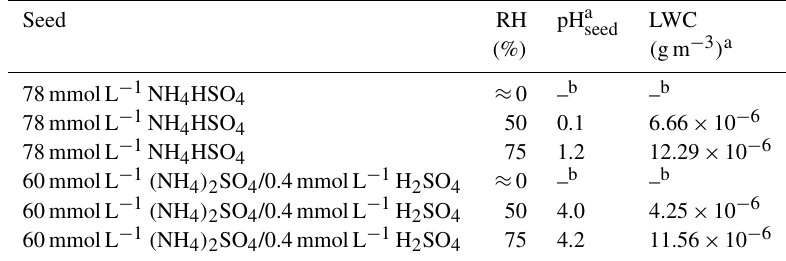
Table 5. LWC and pH of the seed particles calculated with E-AIM.